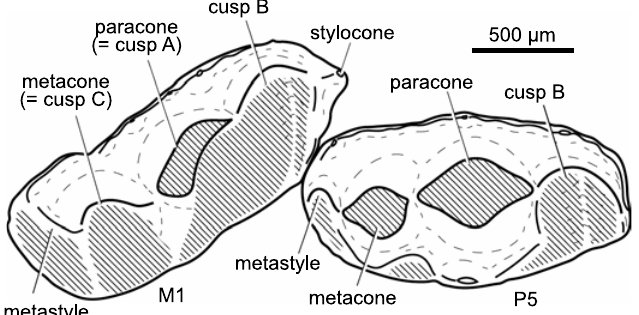
Fig. 5. Illustration of crown morphology of the morganucodontan mamma- liaform Cifelli lestes ciscoensis gen. et sp. nov. (OMNH 80538 (holotype); right P5–M1 in occlusal view. Terms in parentheses label homologs with traditional “triconodont” cusp nomenclature (e.g., Crompton and Jenkins 1968; Rougier et al.